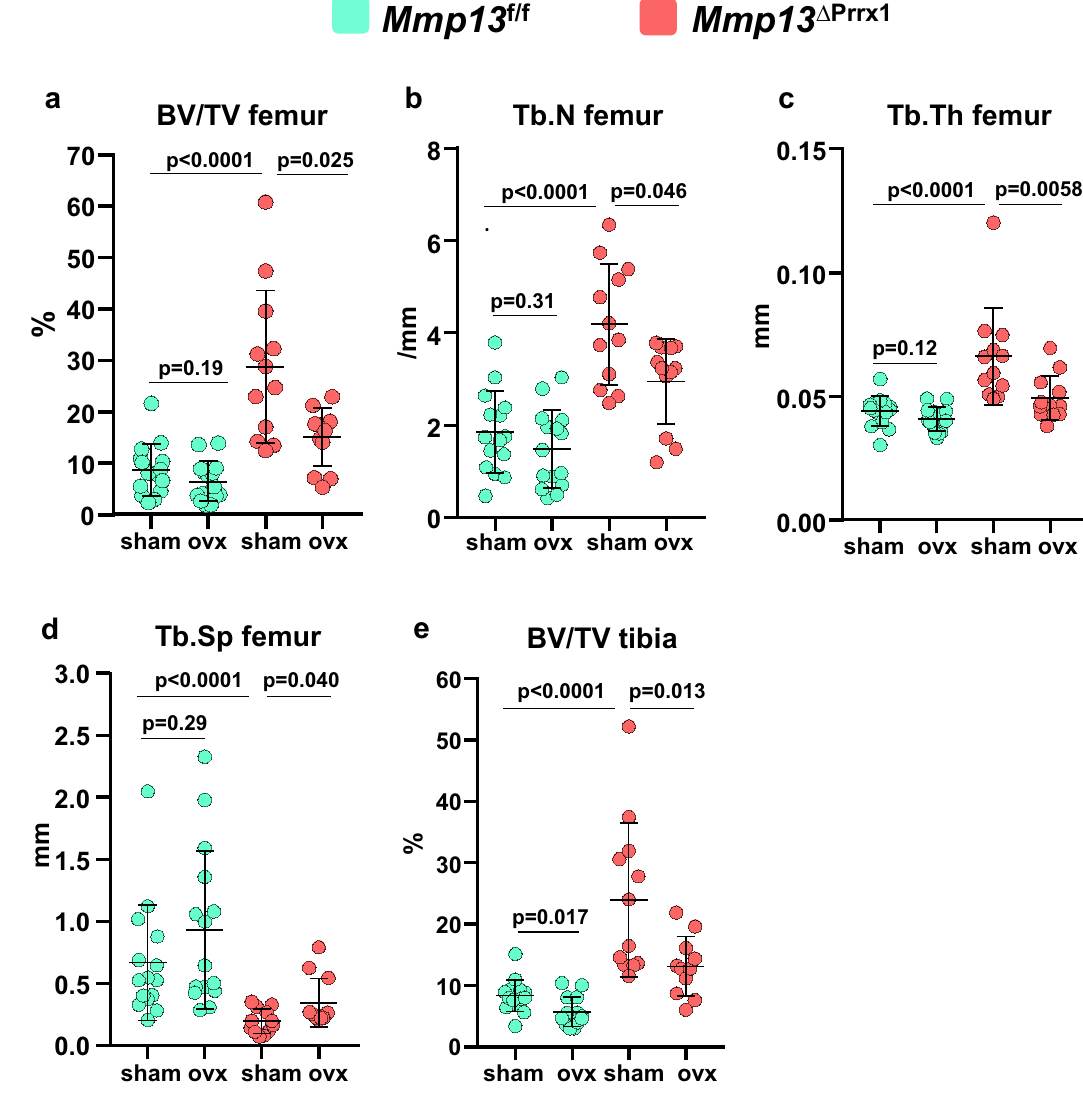
Figure 4. Mmp13 deletion increases trabecular bone but does not affect the loss of bone caused by ovariectomy in this compartment. Femur and tibia trabecular bone were evaluated by micro-CT. ( a ) Trabecular bone volume and ( b – d ) microarchitecture at the distal metaphysis of the femur. ( e ) Trabecular bone volume at the proximal metaphysis of the tibia. Data represent mean ± S.D. (n = 12–15 mice/group); P values by Kruskal–Wallis